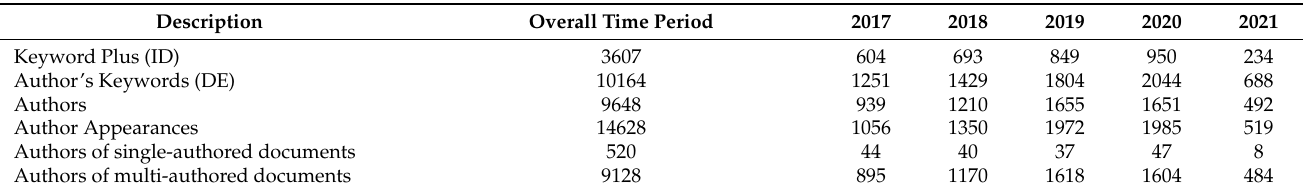
Table 3. Document content and authors, overall period, and per year.